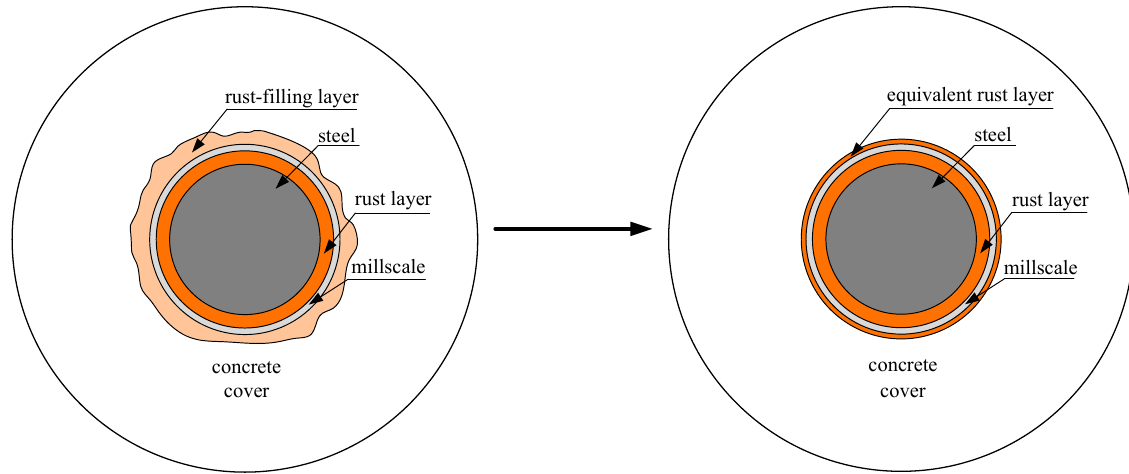
Figure 7. The rust-filling layer is converted to an equivalent rust layer.